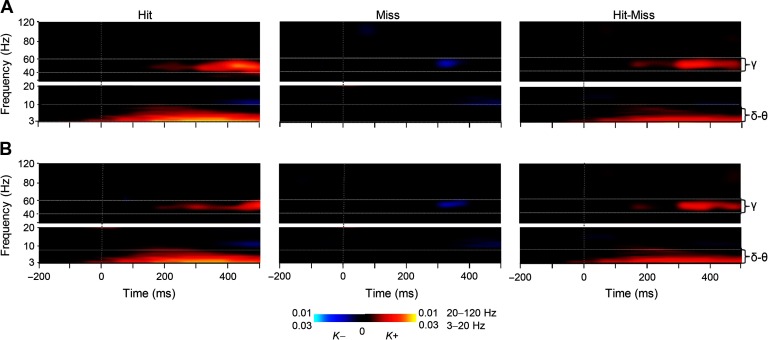
Large-scale delta- and gamma-band synchronization characterizes neuronal processing of perceived but not unperceived stimuli. (A) Time-frequency representations of the extent of significant interareal synchronization as estimated with PLV for perceived (Hit) stimuli, unperceived (Miss), as well as for their difference (Hit-Miss) compared with the prestimulus baseline (N = 12) (Wilcoxon signed-ranked test, p < 0.05, corrected for multiple comparisons). Sustained gamma-band (40–60 Hz) synchronization and delta/theta- (δ/θ, 3–7 Hz) band synchronization were stronger for Hits than Misses. The color indicates the connection densities of positive (K+) and negative (K−) observations, that is, the fractions of connections with a statistically significant positive or negative difference from the baseline level, respectively. (B) Time-frequency representations of the extent of significant interareal synchronization as estimated with iPLV.